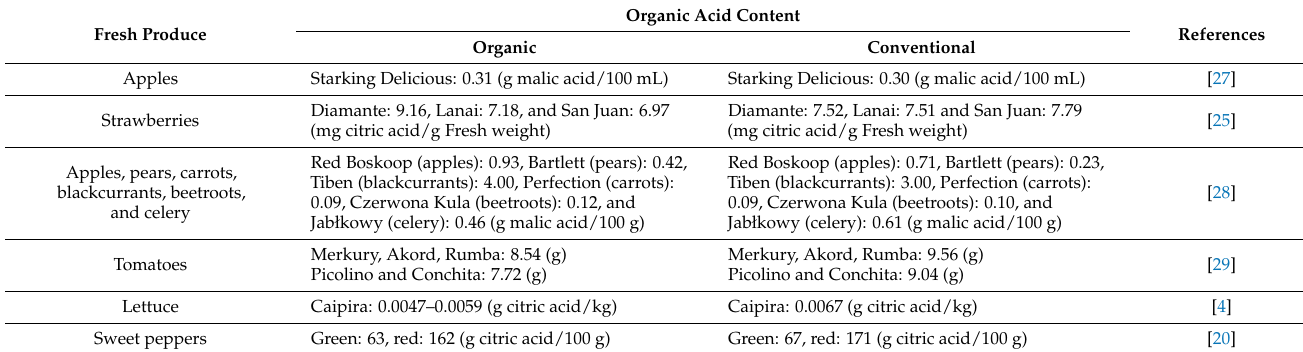
Table 2. The organic acid content of organic and conventional fresh